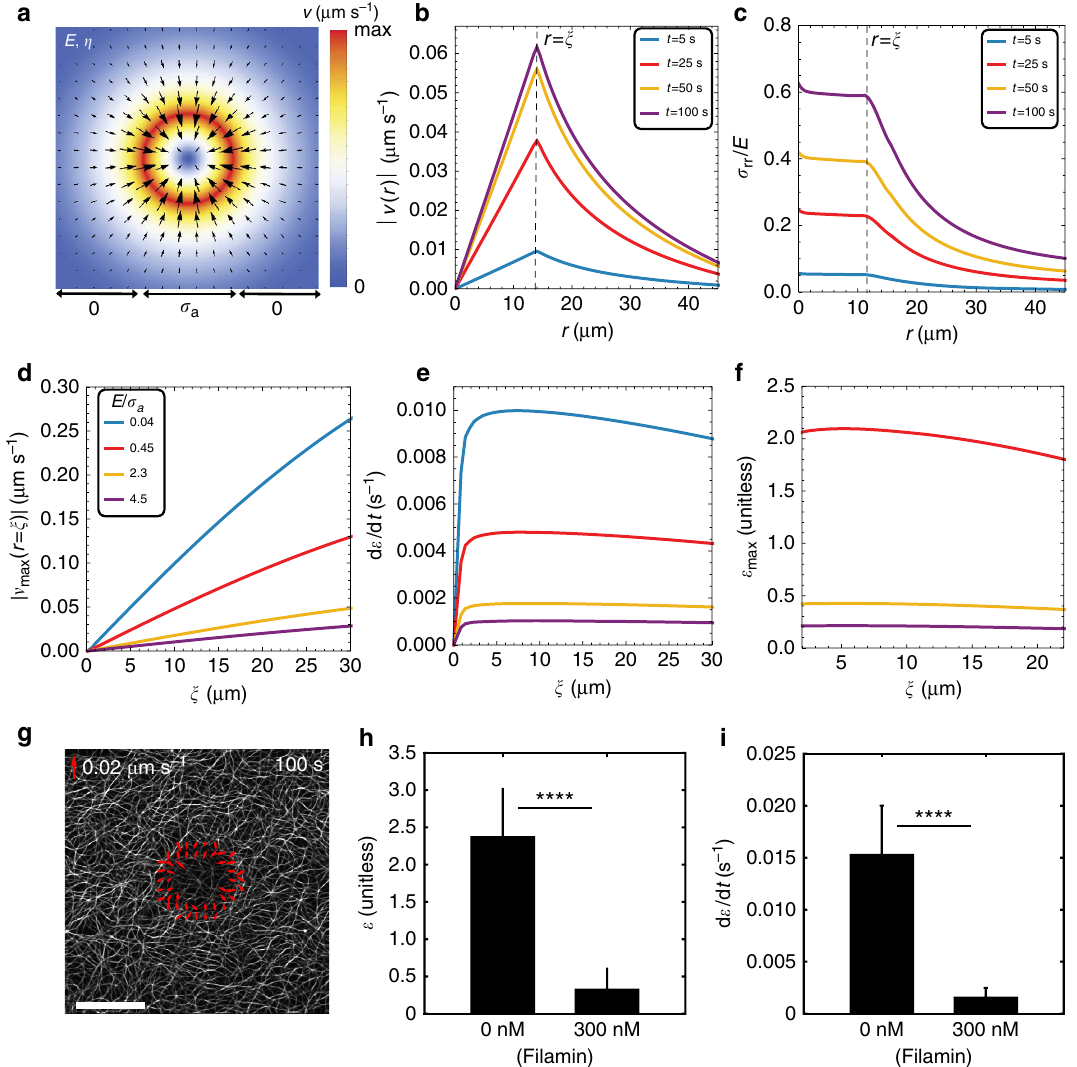
Figure 5 | Minimal physical model of isotropic actomyosin captures telescopic contractile dynamics. ( a ) Active viscoelastic gel model of a central contractile core (with stress s a ) and surrounded by a non-contractile medium (with Young’s modulus E and viscosity Z ). Heatmap represents magnitude of the flow velocity and arrows indicate direction of flow. ( b ) Spatial profile of radial velocity and ( c ) radial stress at different times. ( d ) Maximum velocity, ( e ) maximum strain rate and ( f ) the maximum strain as a function of the radius of the activation zone in a for various values of the parameter E / s a . See Supplementary Table 1 for a list of model parameters. ( g ) F-actin with 45nM Filamin-A ( R C ¼ [Filamin]/[Actin] ¼ 0.035). Red vectors indicate boundary velocity. Scale bar, 25 m m. Strain ( h ) and Strain rate ( i ) of un-crosslinked and filamin-crosslinked actomyosin. Error bars are s.d. **** P o 0.0001 by a Student’s t